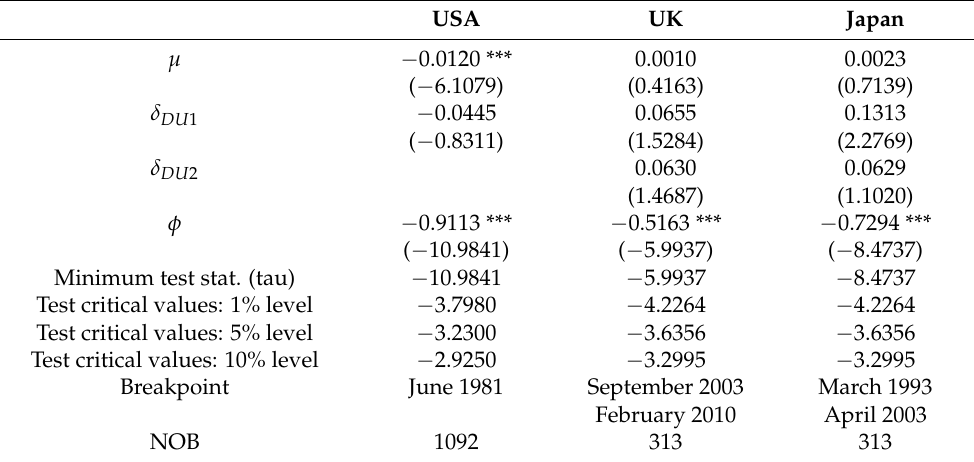
Table 7. Multiple-break unit root tests: Lee and Strazicich test: the crash